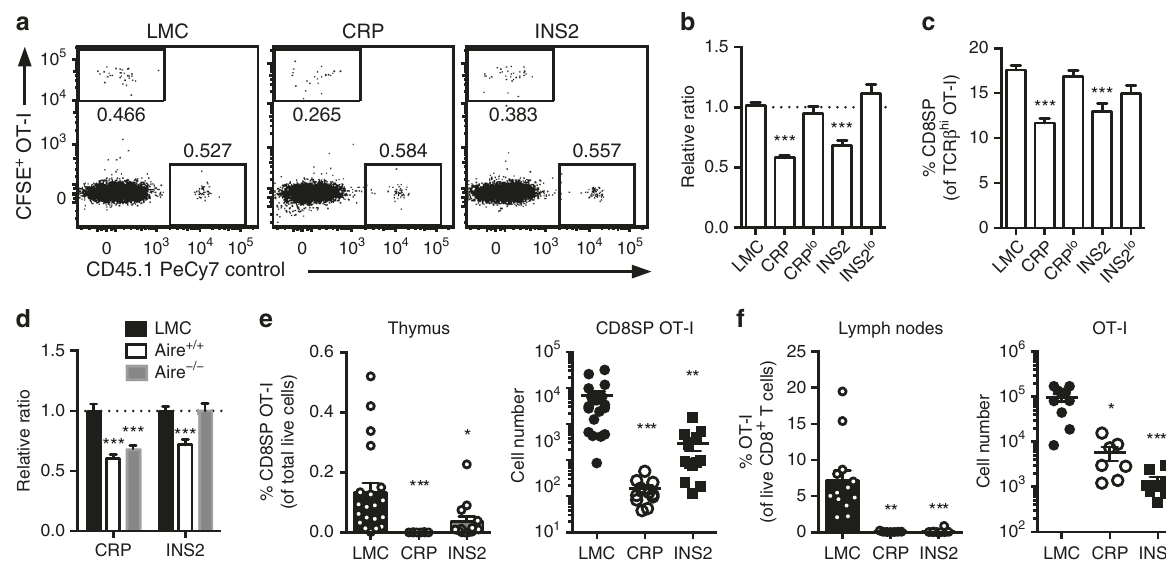
Fig. 2 USA expression in the thymus of CRP and INS2 Tg mice support negative selection of antigen-speci fi c MHC class I-restricted T cells. a Representative fl ow plot and b relative ratio of OT-I:control thymocytes 24 h after overlay on the indicated thymic slices. OT-I:WT control ratios were normalized to the littermate control (LMC) thymus (mean ± SEM, n = 72 LMC, 44 CRP, 12 CRP lo , 26 INS2, 10 INS2 lo ). c CD8 + SP cells among live TCR β hi OT-I cells 24 h after overlay on the indicated thymic slices. (mean ± SEM, n = 100 LMC, 48 CRP, 18 CRP lo , 33 INS2, 10 INS2 lo ). d Relative ratio of OT-I: control thymocytes 24 h after overlay on the indicated thymic slices (mean ± SEM, n = 21 LMC CRP, 17 Aire + / + CRP, 15 Aire − / − CRP, 12 INS2 LMC, 6 Aire + / + INS2, 12 Aire − / − INS2). e , f LMC, CRP and INS2 Tg mice (CD45.2) were irradiated and reconstituted with 1% OT-I (CD45.1) and 99% WT (CD45.1.2) bone marrow. Analysis of the proportion of mature TCR β hi CD8 + SP OT-I thymocytes among total live cells and absolute cell number of CD8SP OT-I in the thymus ( e ) (mean ± SEM, n = 20 LMC, 11 CRP, 13 INS2, from 3 independent experiments) and proportion of OT-I T cells among live CD8 + T cells and absolute OT-I cell number in the peripheral lymph nodes ( f ) of low-density bone marrow chimeras 6 – 8 weeks post-reconstitution (mean ± SEM, n = 12 LMC, 7 CRP, 8 INS2, from 2 independent experiments). All the p -values indicated are calculated by Kruskal – Wallis test followed by Dunn ’ s post-hoc comparisons to LMC, two-sided. * p < 0.05, ** p < 0.01, *** p < 0.001 relative to LMC. Source data are provided as a Source Data fi